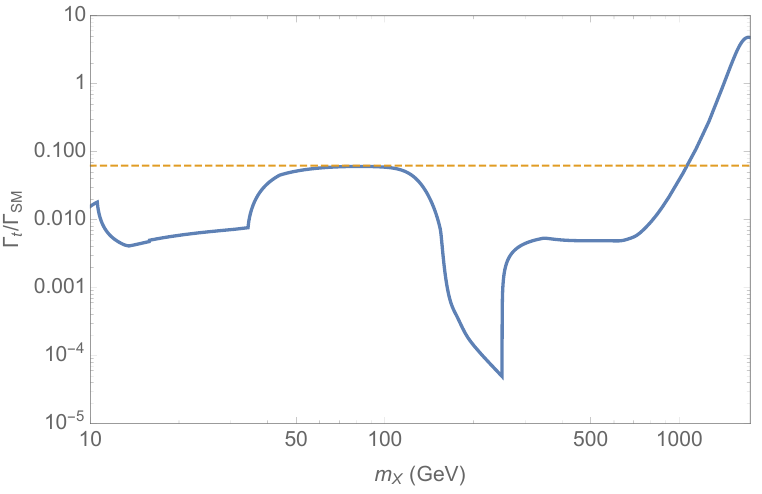
Figure 6 . The ratio of branching fractions of the X into the SM and twin sectors at f=v = 3. The dashed line gives the expected ( v=f ) 2 scaling from the mass mixing; deviations are due to various mass threshold